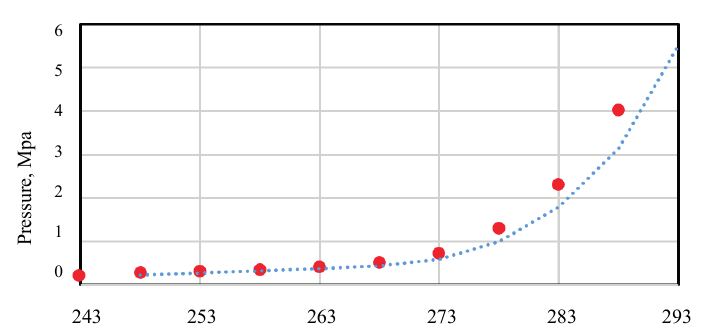
Fig. 7. Equilibrium curve of hydrate formation for the gas, entering the